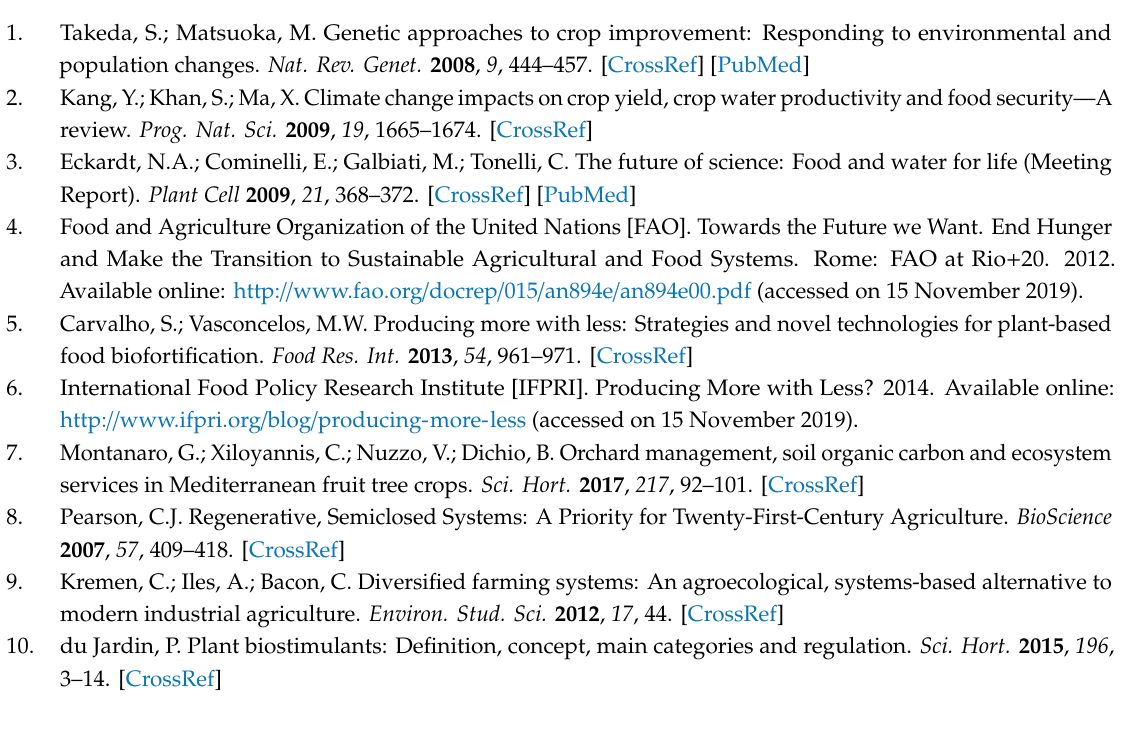
Table S1: Temperatures, humidity (RH%), and radiation (PAR µ mol m − 2 s − 1 ) parameters measured during the trial. Table S2: Sequence of primers used for qRT-PCR analysis; Table S3: Stress Index measurements in corn; Table S4: lists of the 20 most upregulated genes for soybean; Table S5: lists of the 20 most upregulated genes for